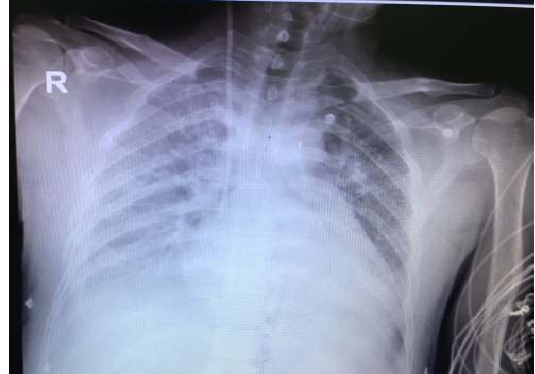
Figure 2: CXR was showing pulmonary